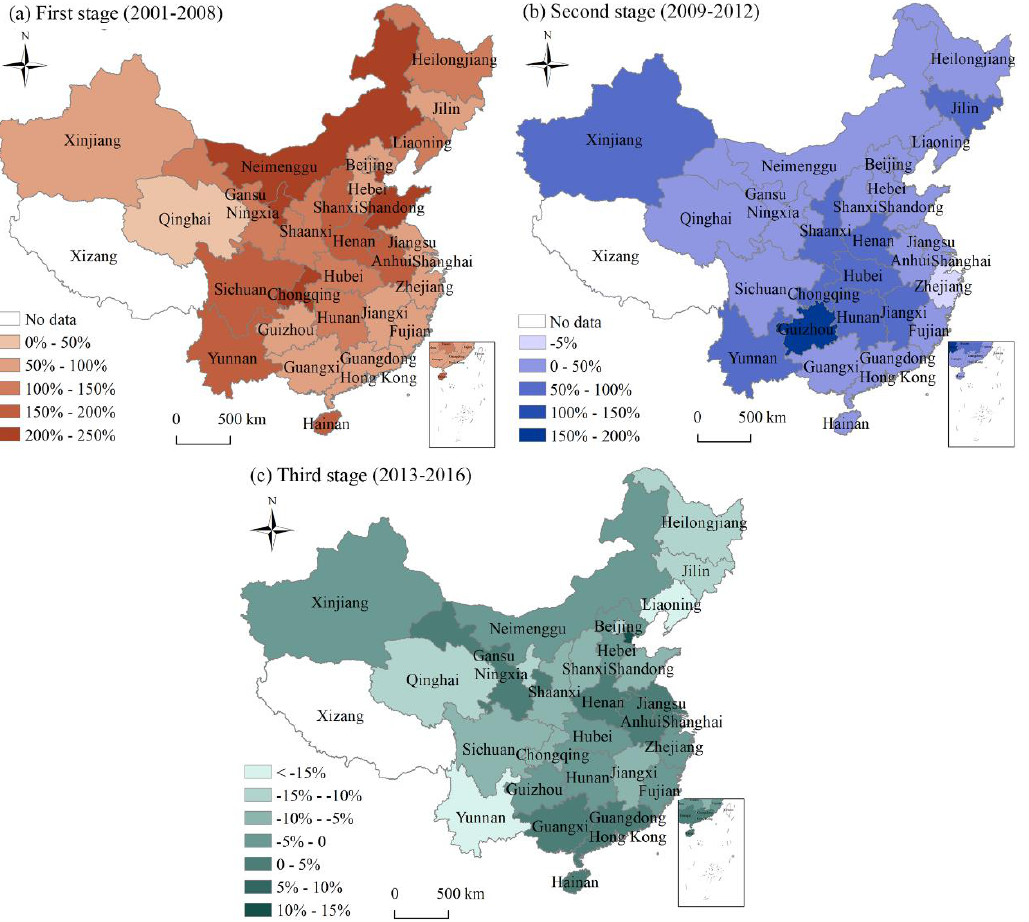
Figure 5. Spatial pattern of average growth index of land finance of the thirty provinces in stages one, two, and three.